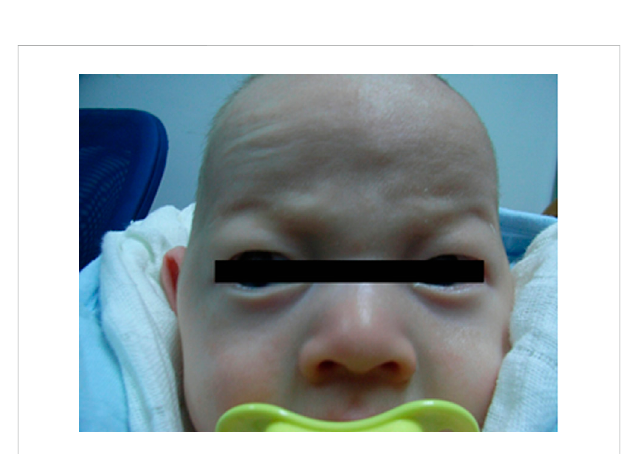
FIGURE 2 DNA sequencing results of family 2. Proband 2 carried homozygous mutation c.1514T > C in the p gene; his father carried heterozygous mutation c.1514T > C/T; his mother was